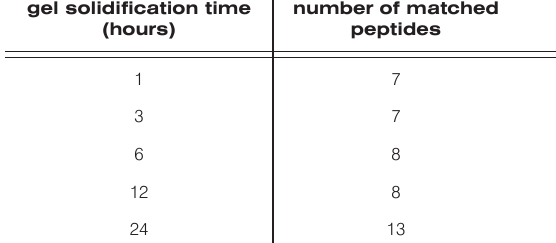
gel solidification time (hours)